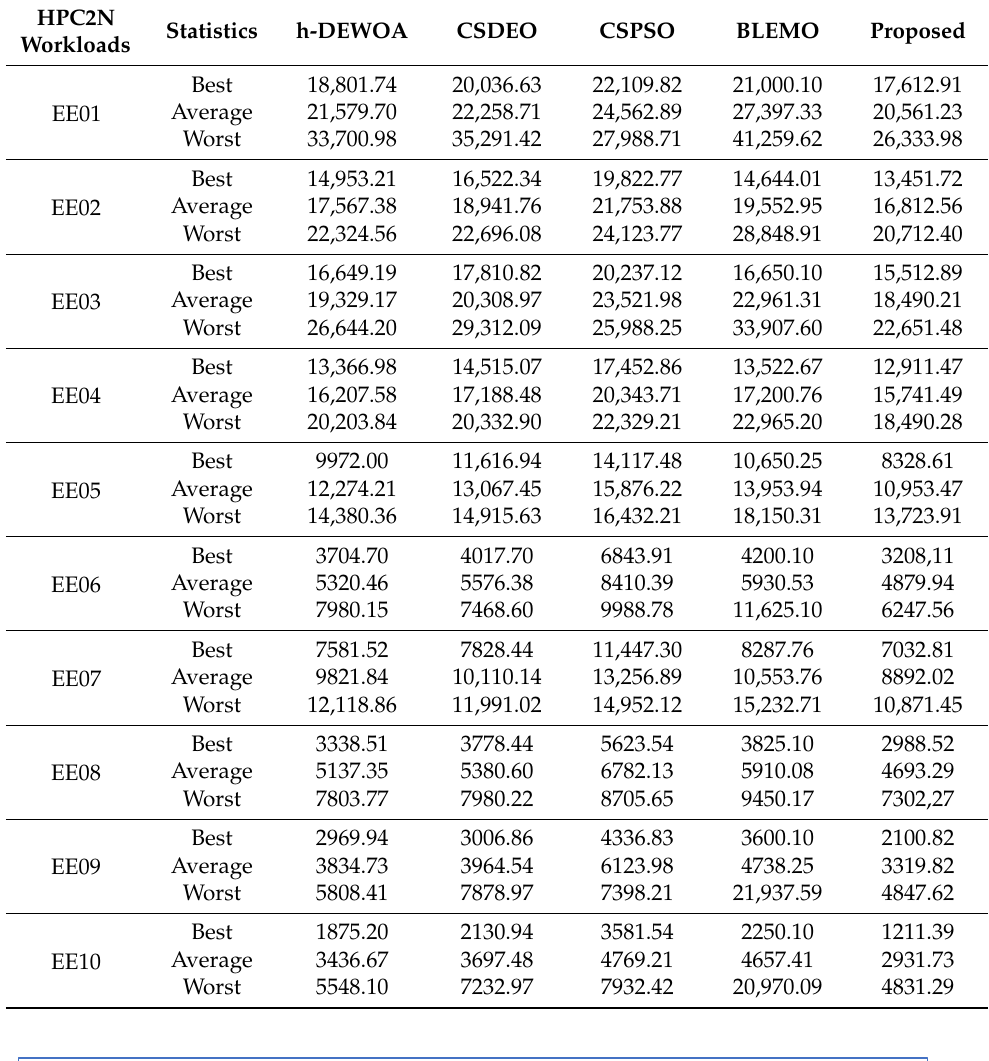
Table 5. Makespan results for HPC2N workload.